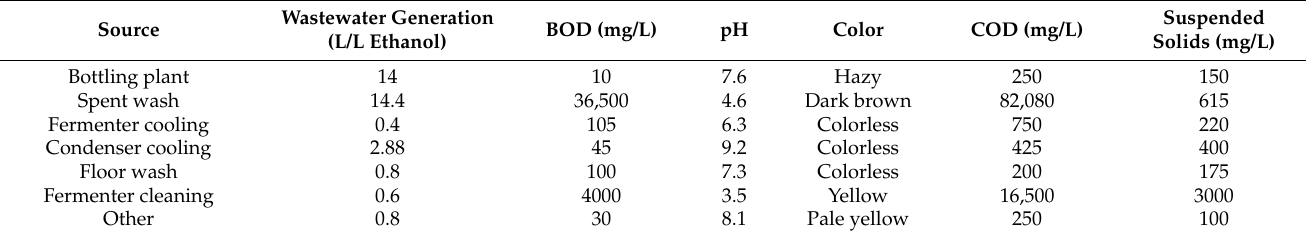
Table 2. Distillery Wastewater